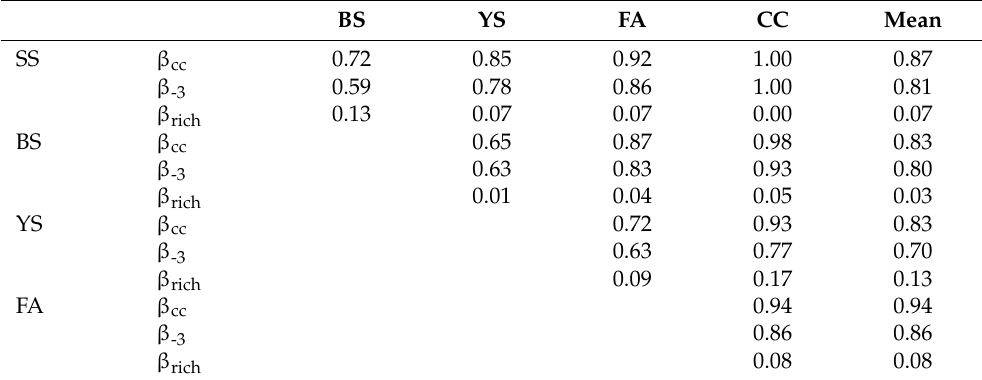
Table 6. Global beta diversity values ( β cc ), species turnover ( β -3 ), and differences in richness ( β rich ) among the Trichoptera assemblages from the Sierra de Juárez, Oaxaca, Mexico.